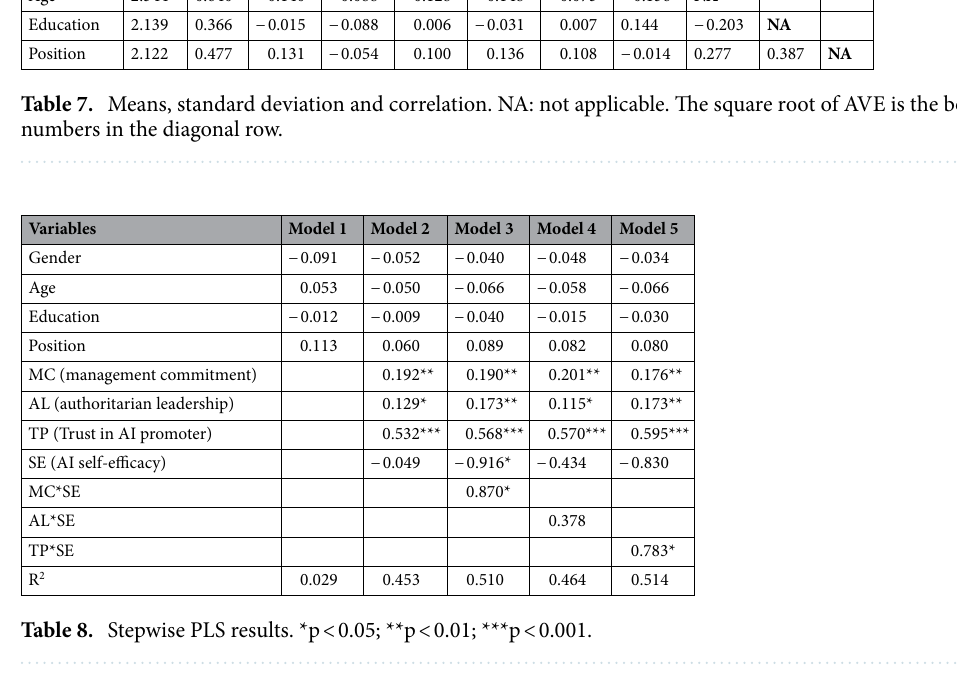
Table 8. Stepwise PLS results. *p < 0.05; **p < 0.01; ***p < 0.001.